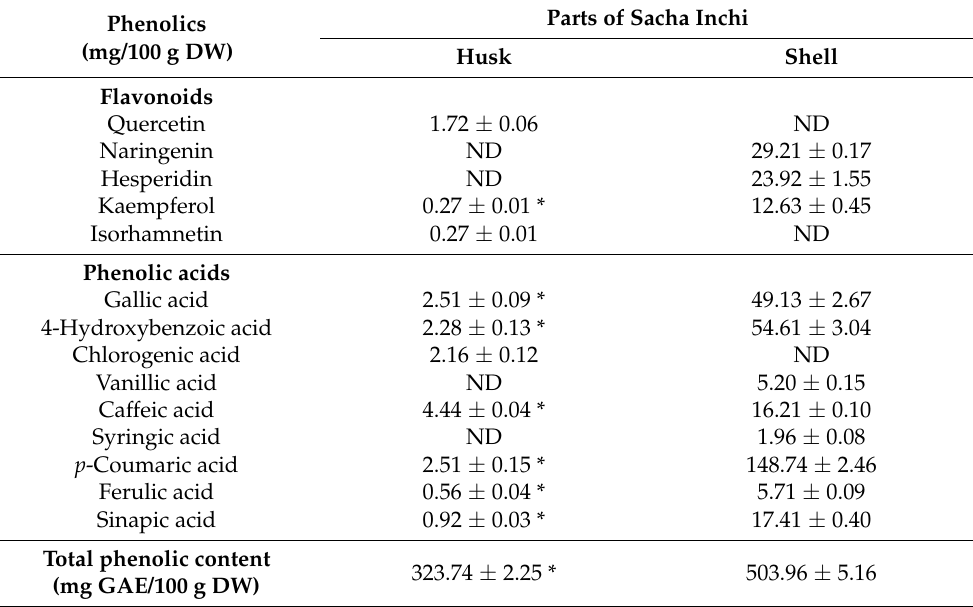
Table 4. Phenolic profiles and total phenolic content in the husk and shell of sacha inchi. Parts of Sacha Inchi Phenolics (mg/100 g DW) Husk Shell Flavonoids Quercetin 1.72 ± 0.06 ND Naringenin ND 29.21 ± 0.17 Hesperidin ND 23.92 ± 1.55 Kaempferol 0.27 ± 0.01 * 12.63 ± 0.45 Isorhamnetin 0.27 ± 0.01 Phenolic acids Gallic acid 4-Hydroxybenzoic acid Chlorogenic